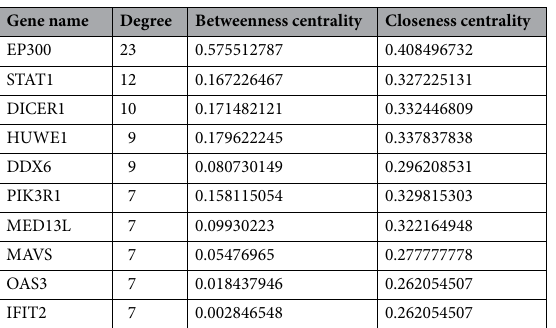
Table 1. The top 10 upregulated genes in the IL-1β/ILA-IL-1β group identified based on the topological parameters at a threshold of degree 6 in the protein–protein interaction network, using the Cytoscape NetworkAnalyzer plug-in.